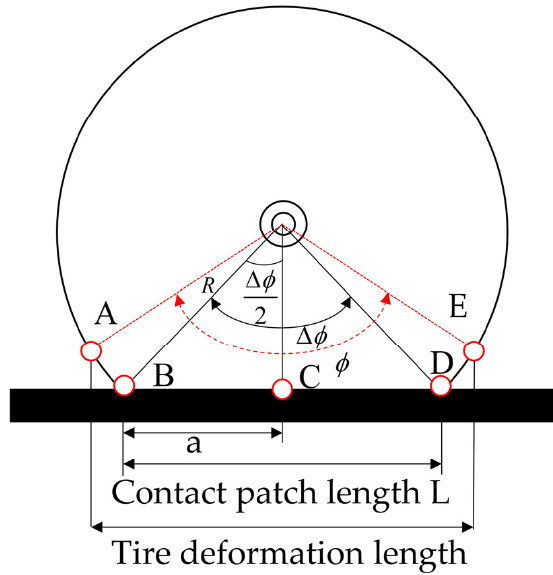
Figure 25. Deformation diagram of tire contact patch.